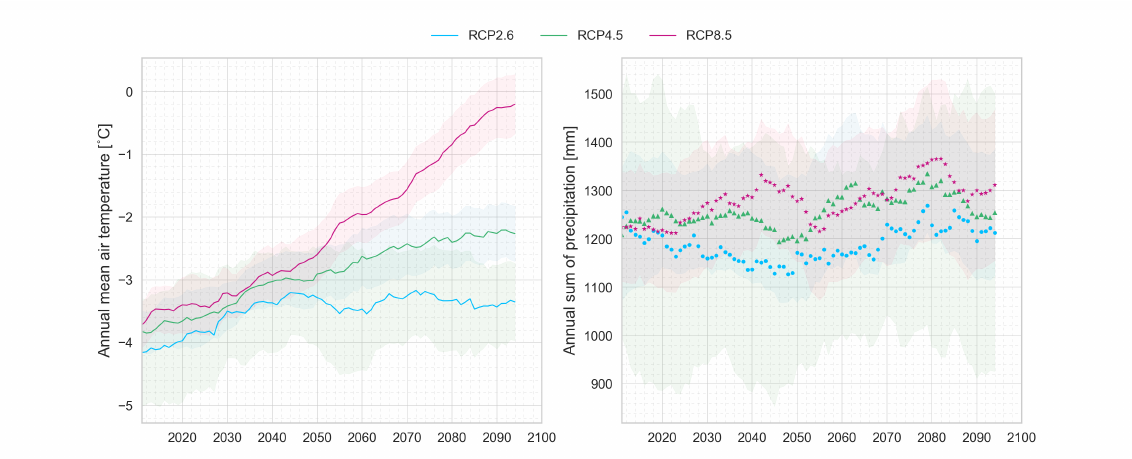
Figure 3. Future multi-model ensemble mean projections of (i) annual mean air temperature and (ii) annual sum of precipitation by using a centered 11-year moving average (both parameters refer to the entire catchment area of the upper Ötztal). Shadows display the full range of the ensembles within the 95% confidence